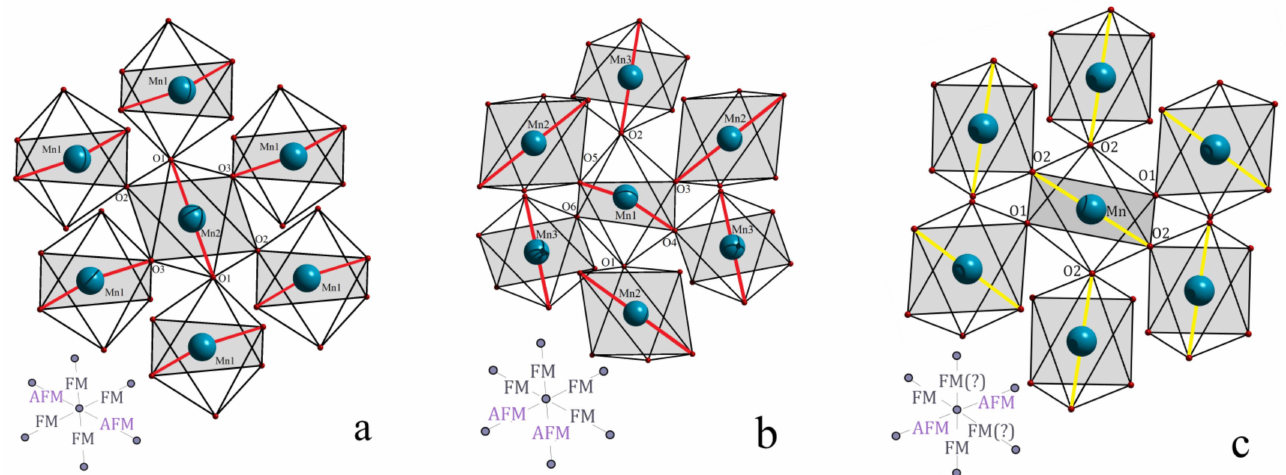
Figure 3. Schemes of the oxygen octahedra of the compounds BiMnO 3+ δ ; ( a ) denotes the scheme specific to the compound with δ = 0.02; ( b ) — δ = 0.08; ( c ) — δ = 0.14); the d z2 orbitals are highlighted in red and yellow colors (yellow color of the d z2 orbitals in case of BiMnO 3.14 compound denotes partial suppression of the orbital ordering which leads to an uncertainty in the type of the exchange interactions Mn-O(2)’-Mn, marked by